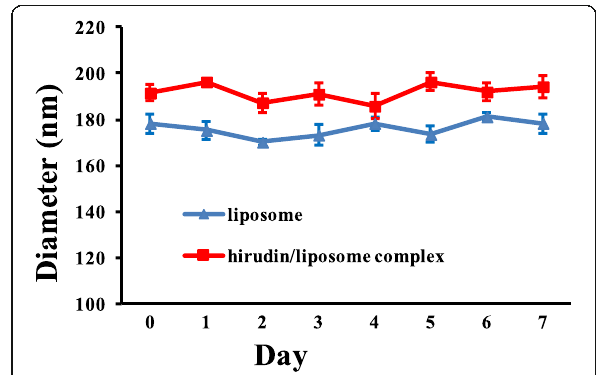
Fig. 2 DLS spectra showing the particle size of the liposome and the hirudin/liposome complex did not change significantly within one week